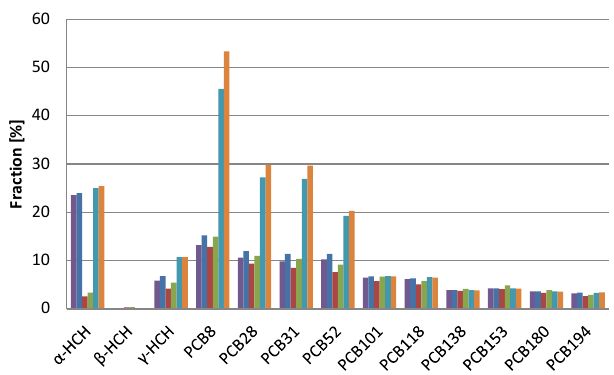
Figure 3. The fraction of the compounds found within the Arctic relative to the mass in the entire model domain calculated from the annual averages in the last simulated year for ES19 (purple), E19 (red), S19 (turquoise), ES20 (blue) E20 (green), and S20